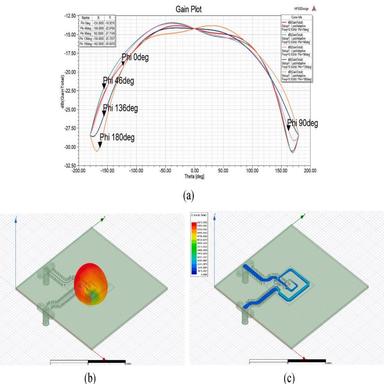
Simulated radiation features of microstrip antenna fixture:(a) planar coordinate chart; (b) 3D radiation pattern; (c) E field (magnitude).